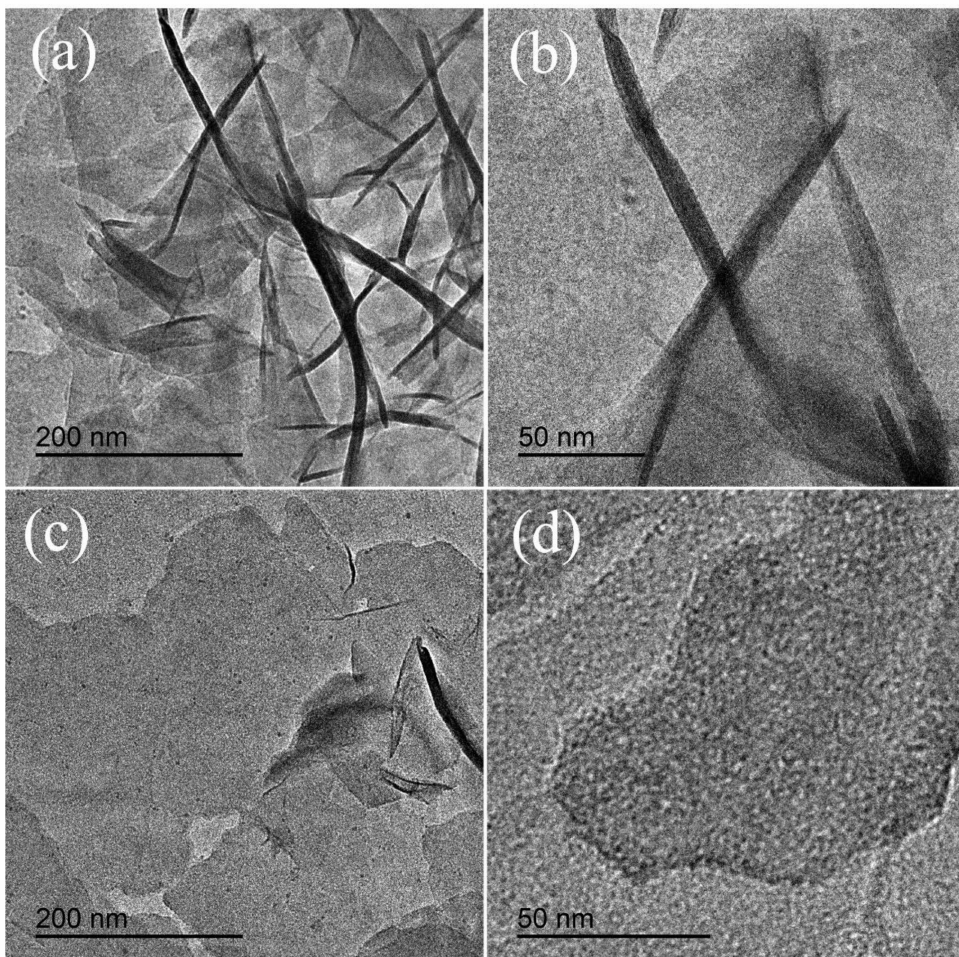
Figure 3. Transmission electron microscopy (TEM) images of S-Ni(OH) 2 /MLG (( a ): low magnifica- tion, ( b ): high magnification) and L-Ni(OH) 2 /MLG (( c ): low magnification, ( d ): high